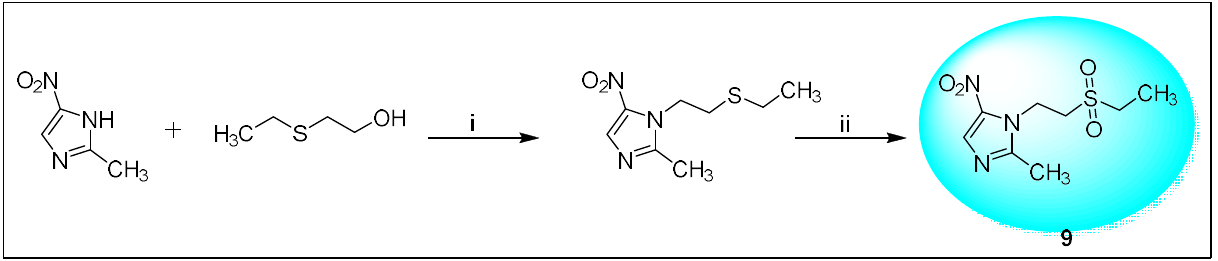
Figure 13. Activity profile of Tinidazole 9 [100,116,118,119]. Chandorkar et al. (2007) developed a benign method for the synthesis of Tinidazole 9 (Scheme 32). In this method, 2-methyl-5-nitroimidazole underwent condensation with 2-ethyl-thio-ethanol by using MoO 3 /SiO 2 as a catalyst and produced 1-(2-ethyl-thio-ethanol)-2-methyl-5-nitroimidazole, which further underwent oxidation in the presence of hydrogen peroxide and MoO 3 /SiO 2 and produced Tinidazole 9 . The catalyst used in this reaction can be recycled five times without any loss in selectivity [120].